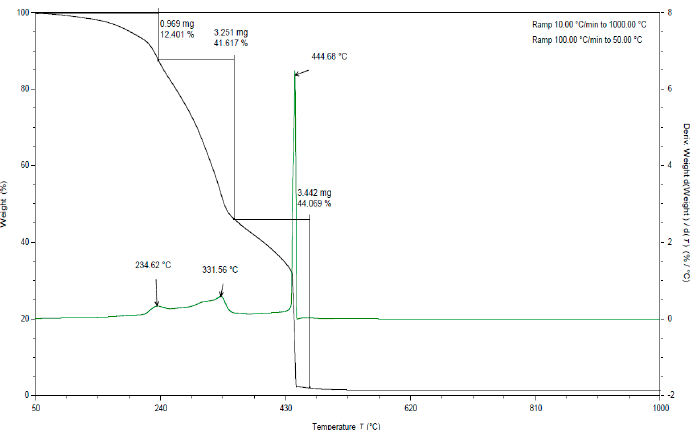
( d ) sample 2 enlarged. Analysis under nitrogen atmosphere.